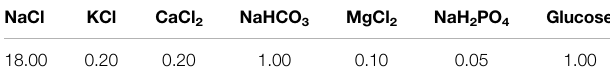
TABLE 1 | The chemical composition of SBF solution (g).